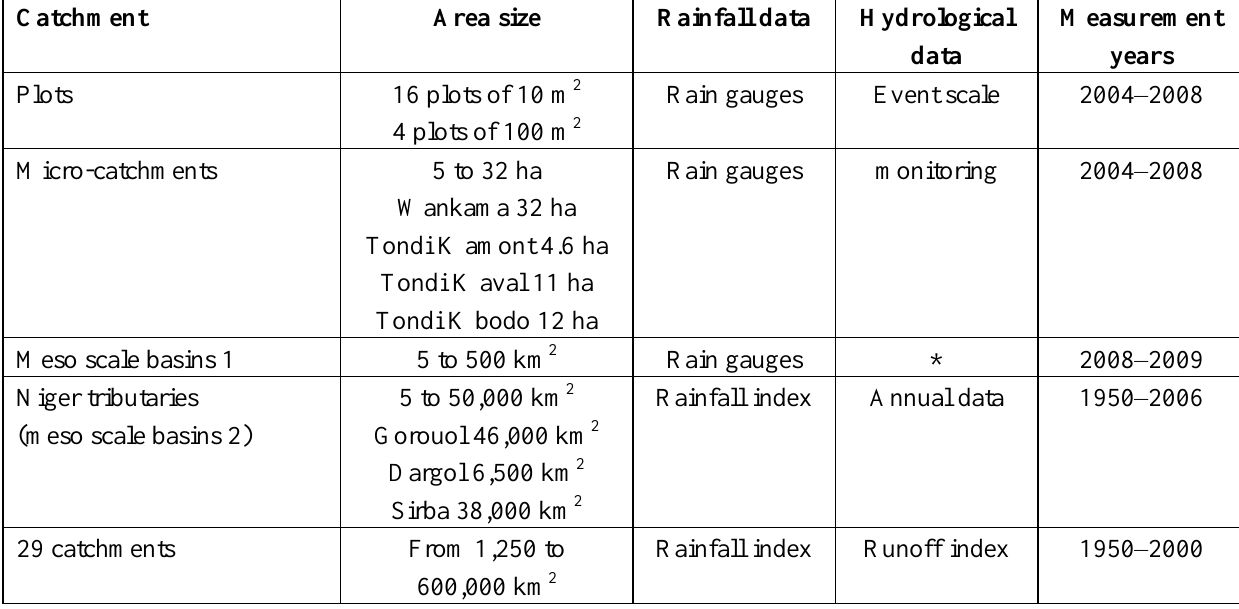
Table 1. Data, area and periods monitored, rainfall and runoff data used in this